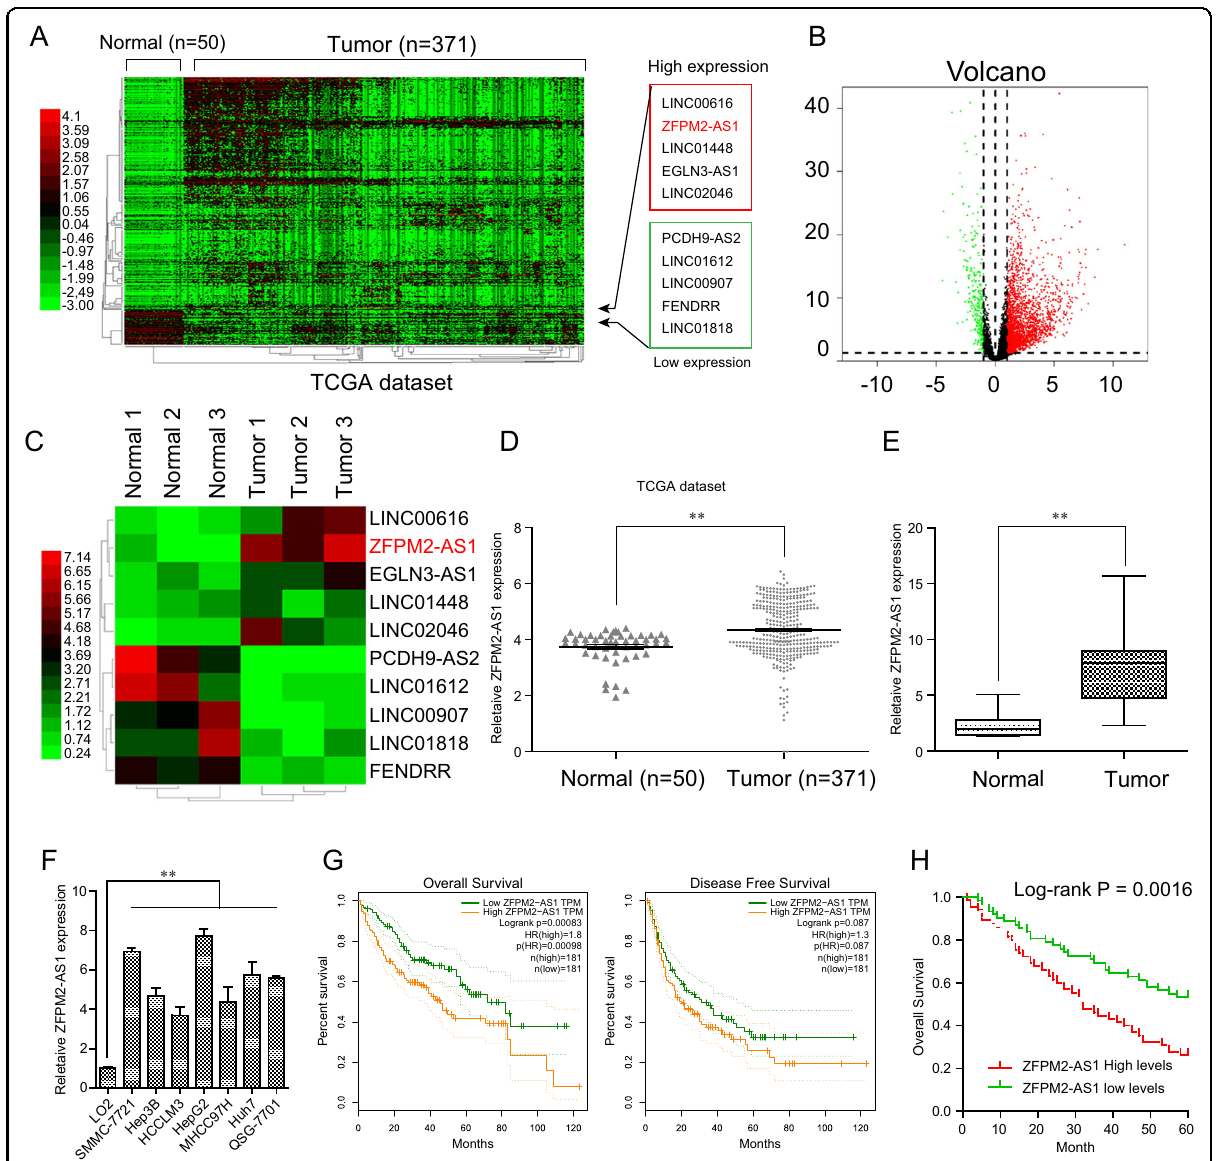
Fig. 1 ZFPM2-AS1 was upregulated in HCC specimens and cells. A Heatmap of differentially expressed lncRNAs in HCC samples using TCGA data set analysis. B Volcano map of differentially expressed lncRNAs. C Real-time PCR assays detected the levels of selected fi ve upregulated and fi ve downregulated lncRNAs in three paired HCC tumor samples and adjacent normal tissues. The results showed by heatmap form. D Relative ZFPM2- AS1 expression in HCC specimens using TCGA data set analysis. E Real-time PCR analyses determined ZFPM2-AS1 levels in 127 paired HCC tumor specimens and adjacent normal samples. F ZFPM2-AS1 levels in HCC cell lines were evaluated by qPCR analyses. The L02 cell line was used as a reference. G GEPIA algorithm analyzed the overall survival and disease-free survival of HCC patients with high or low expression of ZFPM2-AS1. H Overall survival analyses of 127 HCC patients with high or low ZFPM2-AS1 expression. Data are presented as the mean ± SD from three independent experiments. * P < 0.05, ** P <